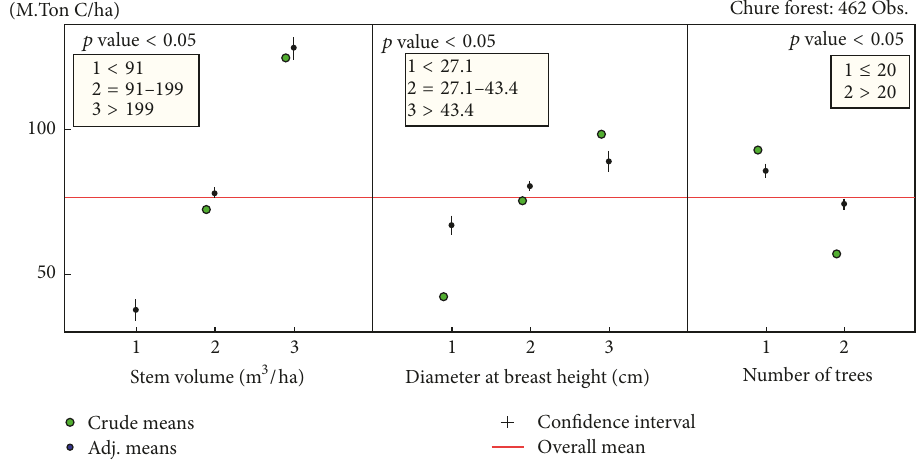
Figure 5: The confidence interval plots of the variables: stem volume, dbh, and the tree frequency.